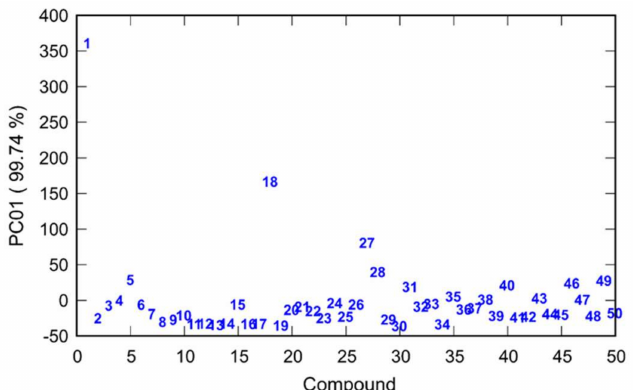
Figure 3. Classification of compounds 1–50 based on values calculated by PCA performed on the mean-centered covariance matrix of their inhibition of AChE and BChE. (Compound labels: 1